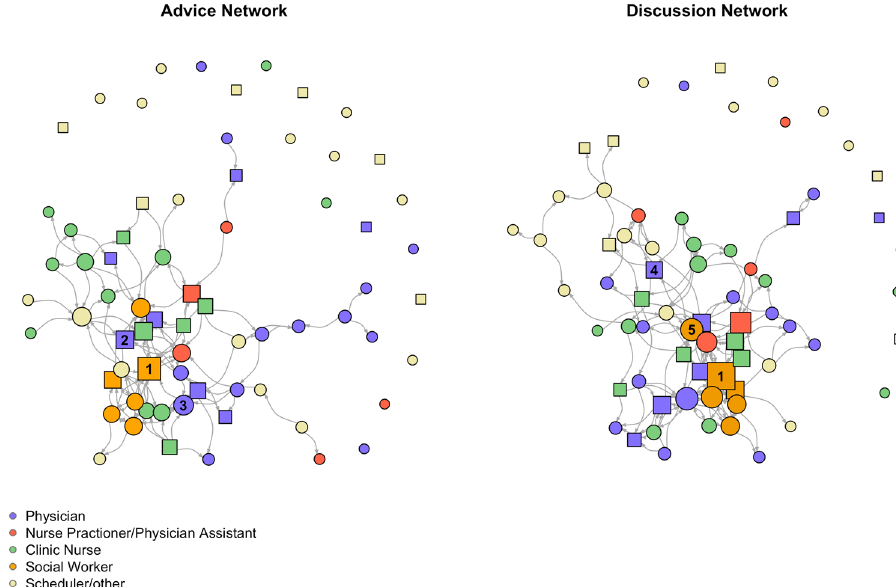
Fig. 1 Advice and discussion networks of oncology clinicians. Nodes sized proportionate to indegree, i.e., the number of times nominated. Squares indicate people who have referred patients to the survivorship clinic, circular nodes have not previously referred patients to the clinic. The numbered nodes are the individuals with the highest betweenness centrality.